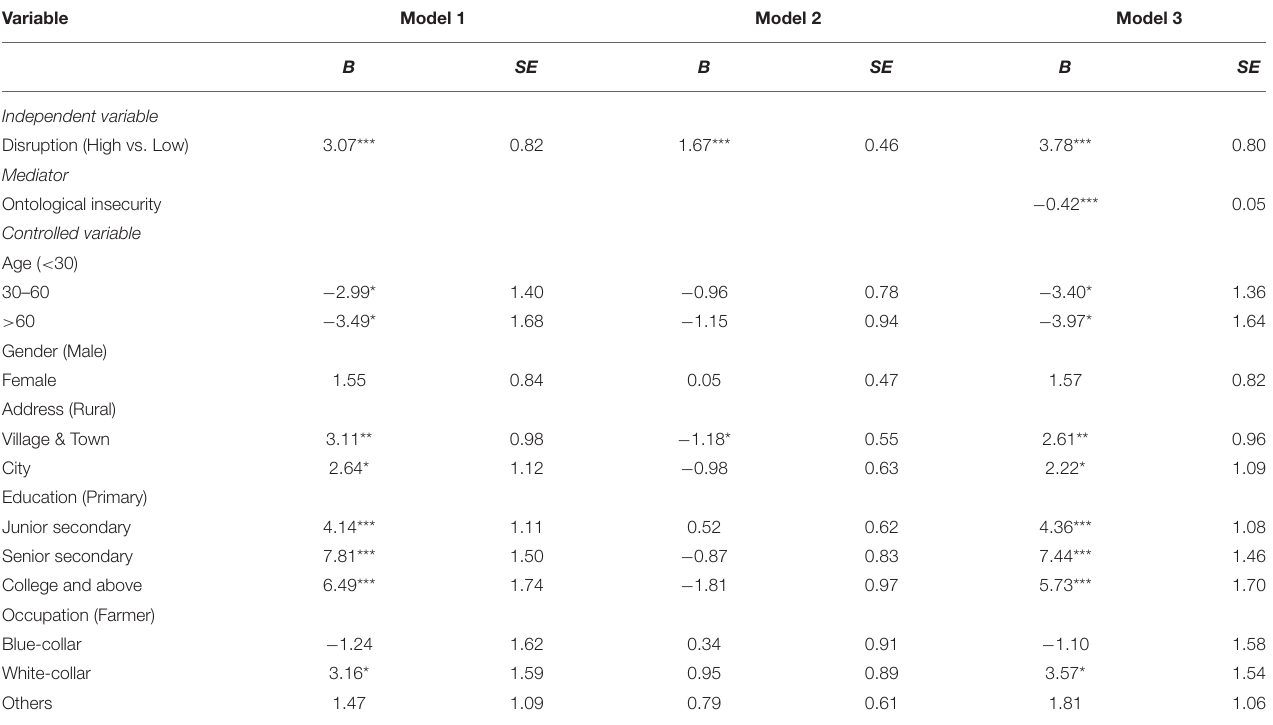
TABLE 3 | Model test of mediating effect of ontological insecurity.